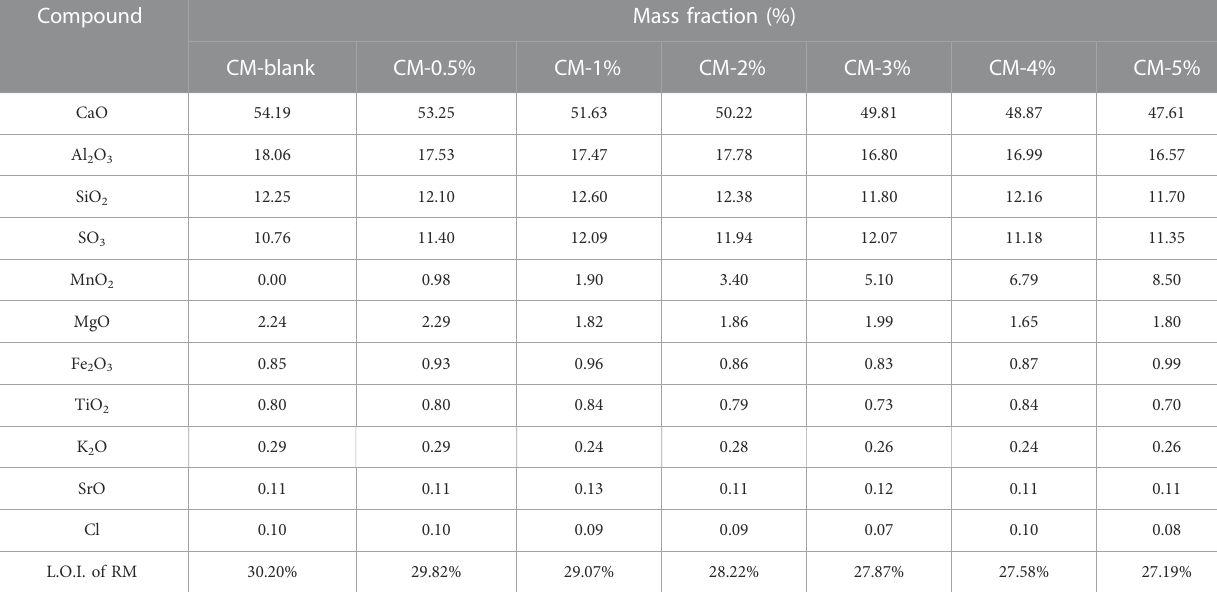
TABLE 2 Composition of the Mn doped clinker material samples. Compound